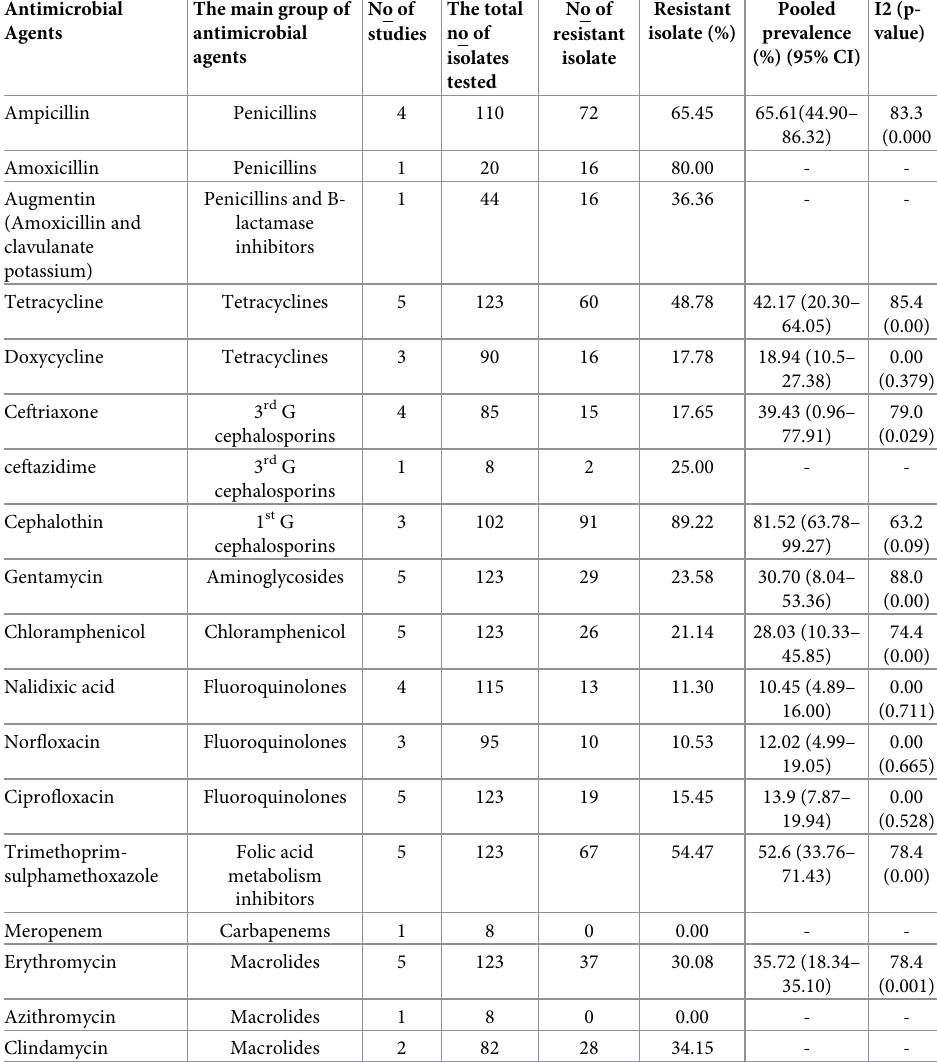
Table 8. Pooled prevalence of Campylobacter spp. resistance to different antimicrobial agents in Ethiopia. Antimicrobial